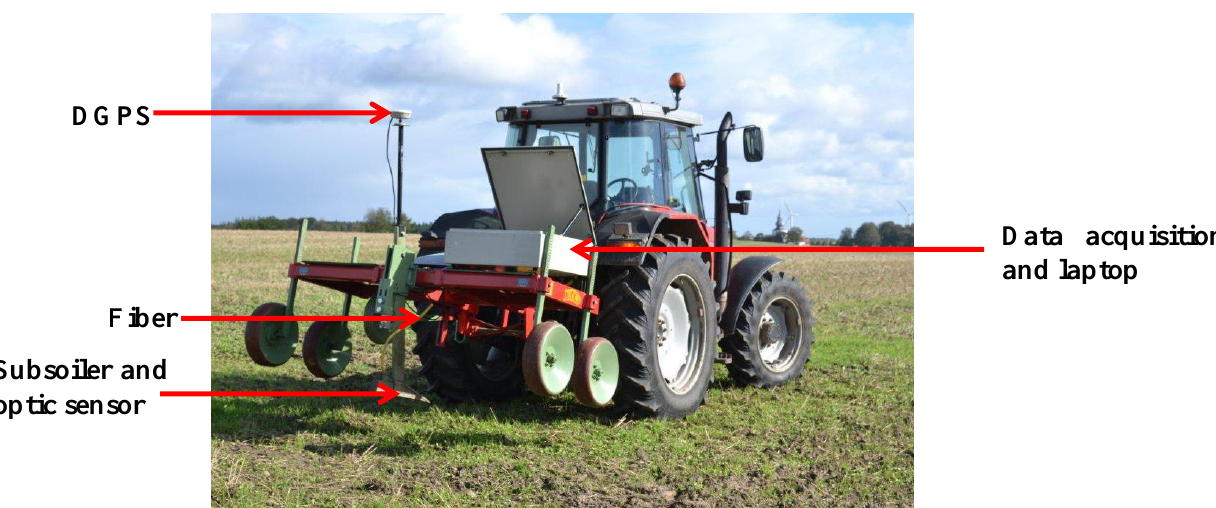
Figure 1. The on-line visible and near infrared (vis-NIR) soil sensor attached to the three point linkage of a tractor